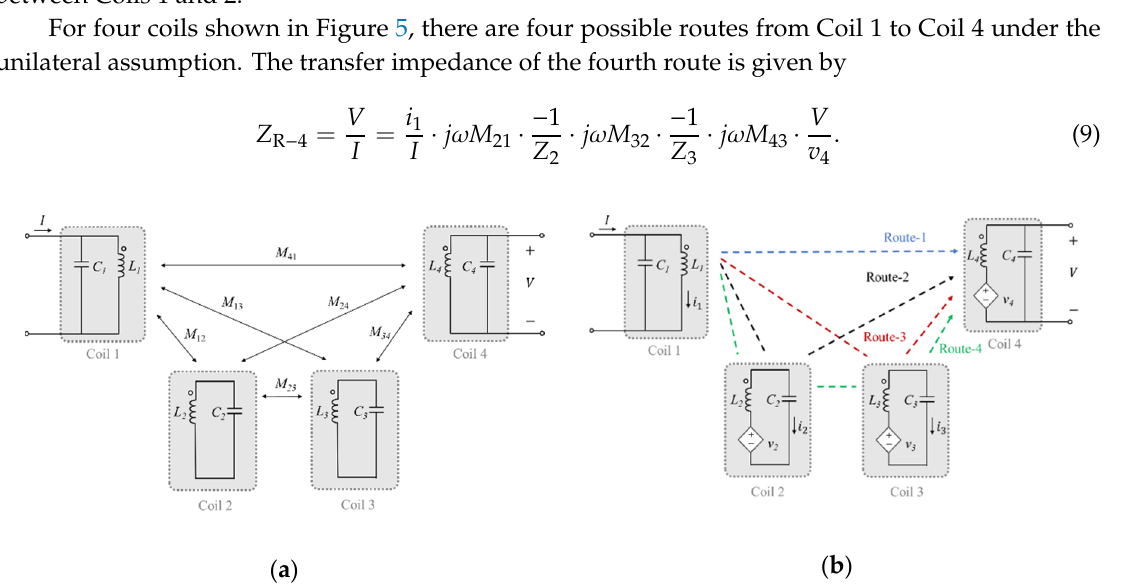
Figure 5. The equivalent circuit model: ( a ) Four coils with ideal mutual inductances; and ( b ) with four routes.